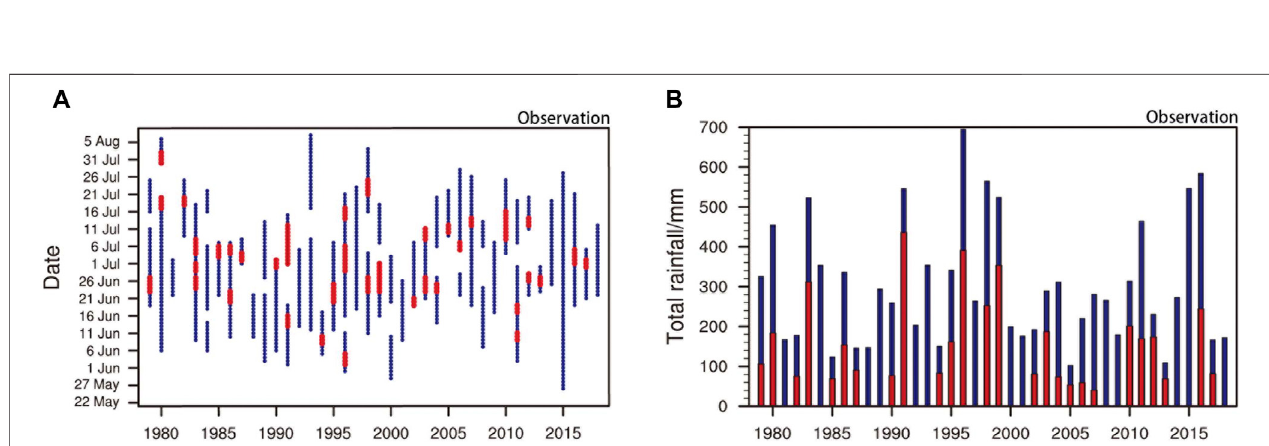
FIGURE3|(A) DistributionsofPHREs(redmarks)andtypicalMeiyuperiods(bluemarks)overtheMLYRduring1979-2018 (B) Theaccumulatedprecipitationthat occurs during PHREs (solid red bars, units: mm) and Meiyu periods (solid blue bars, units: mm).